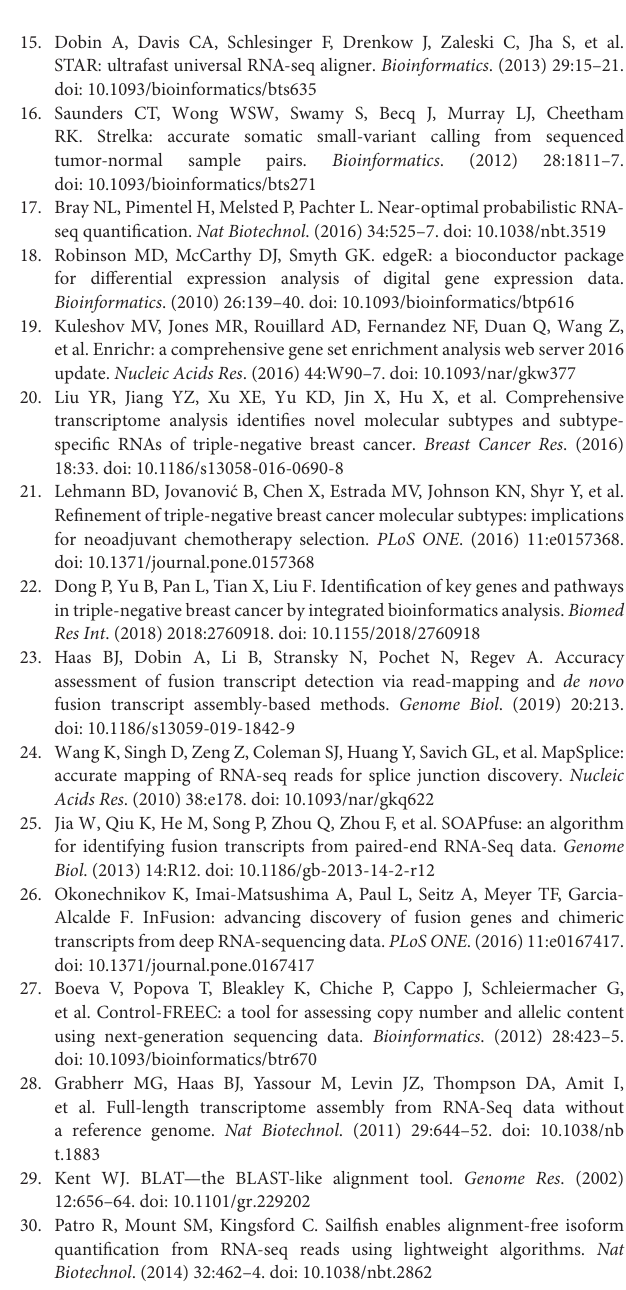
Table S4 | Fusion genes in 4T1, including predicted positions of breakpoints, number of junction reads, and spanning read pairs and the program that detected a fusion. Table S5 | Gene expression in 4T1 and BALB/c mammary gland in TPM. Table S6 | Differential gene expression in 4T1 vs. BALB/c mammary gland, showing log fold change, FDR, and baseline expression values. Table S7 | Gene set and pathway enrichment in differentially expressed genes of 4T1 cells for upregulated and downregulated genes in GO gene sets and KEGG pathways, respectively (sheets are labeled “up GO”, “up KEGG”, “down GO”, and “down KEGG”, respectively).